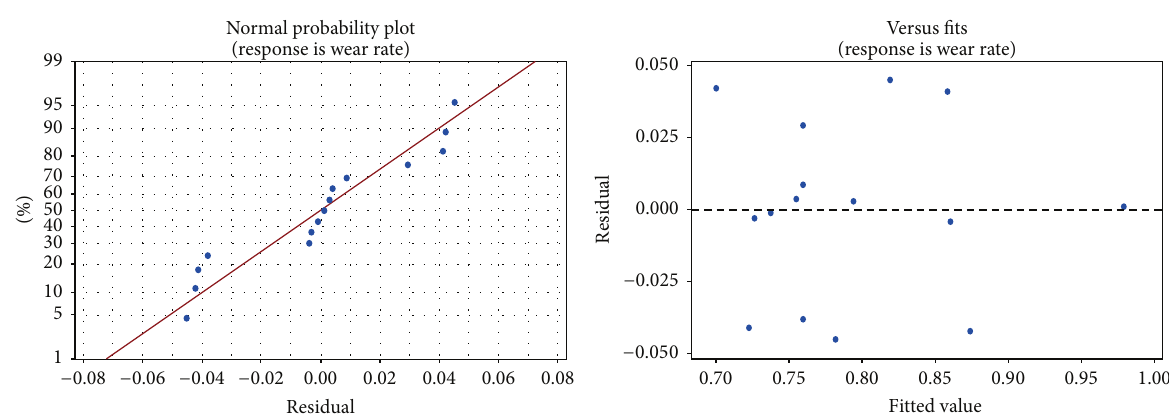
Figure 6: Normal probability plot, versus fits, histogram, and versus order for wear